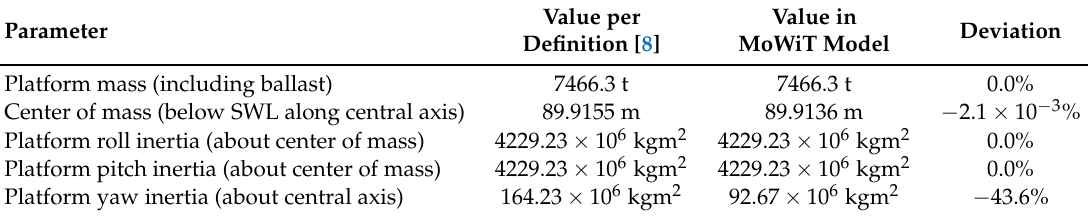
Table 2. Mass-related properties of the OC3 spar-buoy, prescribed values in comparison with the model